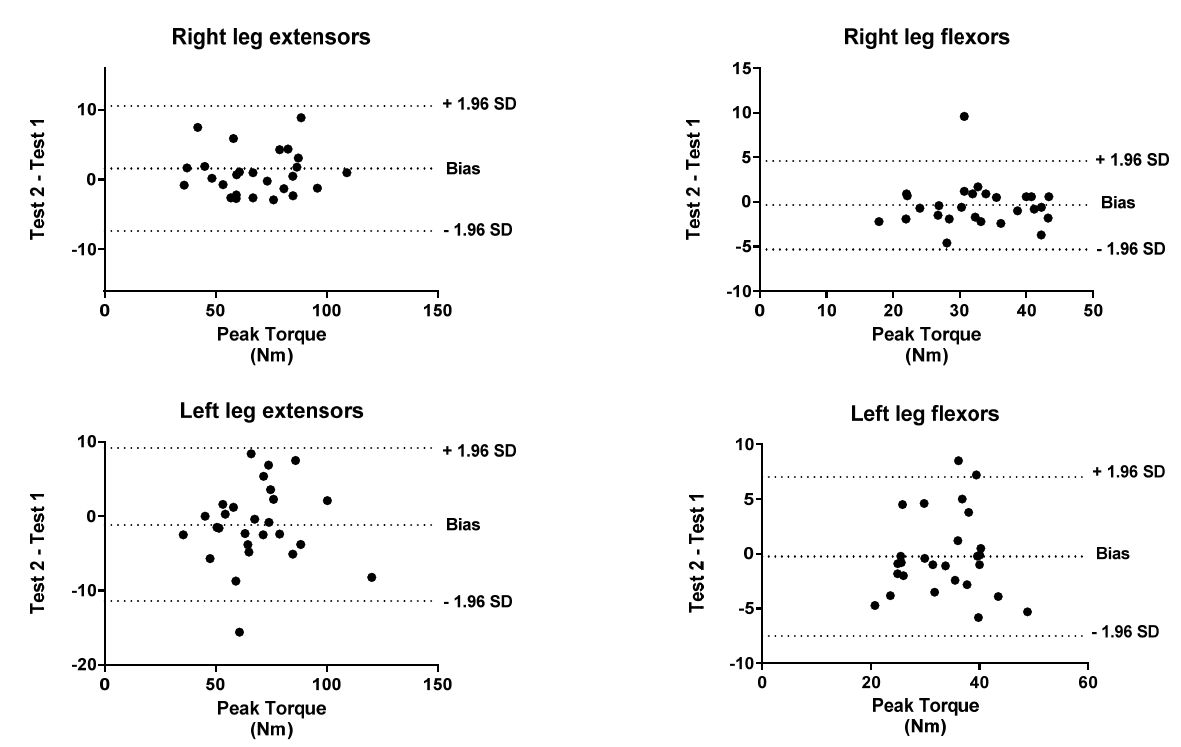
Figure 3. Women Bland–Altman peak torque analysis for Right and Left Legs in flexion and Exten- sion.